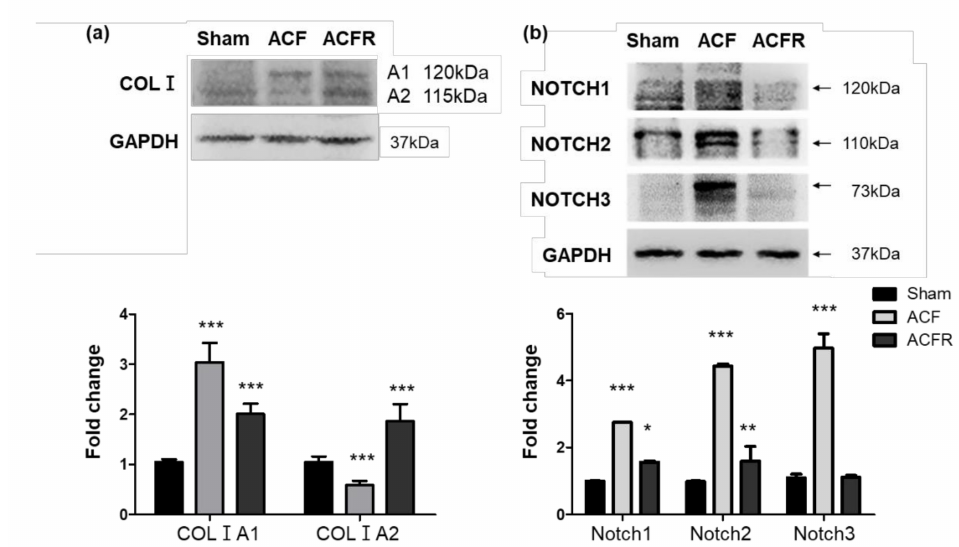
Figure 5. E ff ect of dynamic stretch on collagen IA2 to A1 isoform and Notch3 activation in ACF animal model. After 4 months of ACF, we then closed the aortocaval fistula for one month (ACFR). ( a ) Western blot showing collagen IA2 to A1 expression in total lung cell lysis. The relative expression level of each protein was quantified by densitometry and normalized to the expression level of GAPDH. ( b ) Western blot showing Notch1, 2, and 3 expression in total lung cell lysates. The relative expression level of each protein was quantified by densitometry and normalized to that of GAPDH. Each value represents the mean ± SE of 4 independent experiments. * p < 0.05, ** p < 0.01 and *** p < 0.001 versus sham group, one-way ANOVA, Dunnett’s post